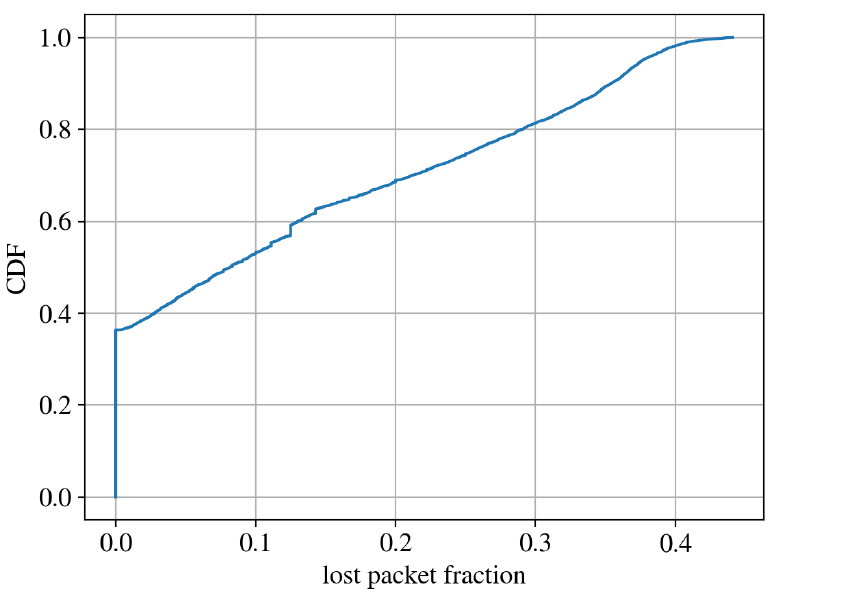
Figure 10. Plot of CDF of devices in function of percentage of packet